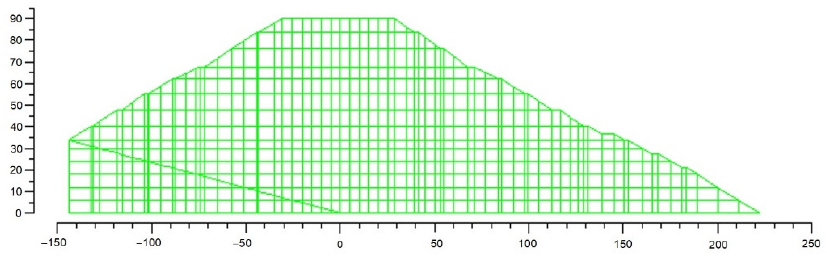
Figure 8. Cross-sectional view of the 2nd Tomei Expressway embankment in the Kasesawa area in Japan.